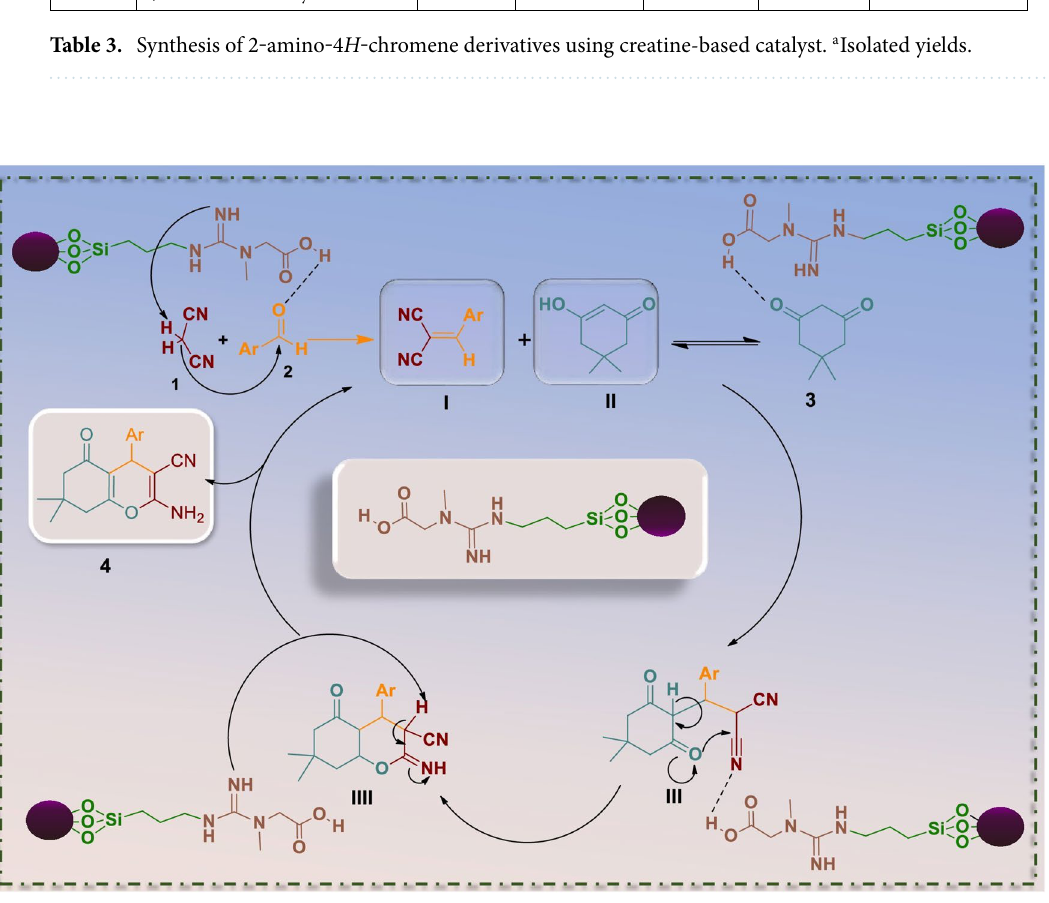
Figure 7. Proposed mechanism for the synthesis of 2 ‐ amino ‐ 4 H ‐ chromene derivatives in presence of Fe 3 O 4 @